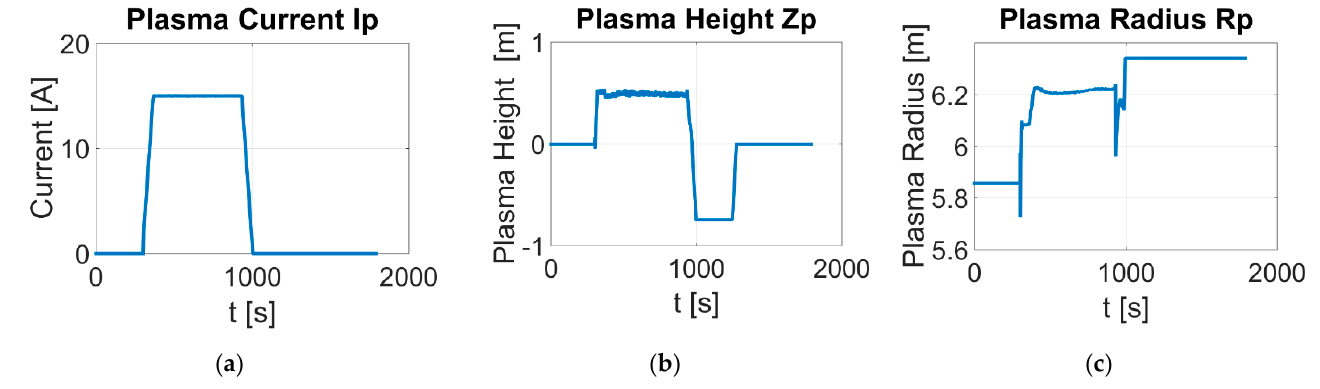
Figure 11. Testcase#1. The plasma current ( a ), the radius ( b ), and the height ( c ) of the barycenter of the plasma during the scenario.